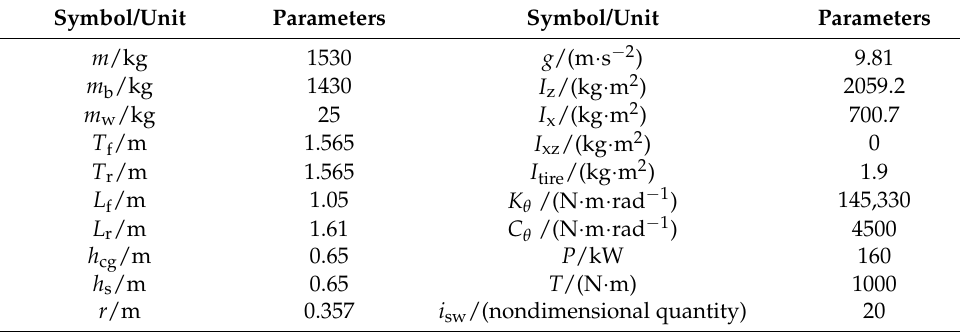
Table 2. Description of SUV parameters.